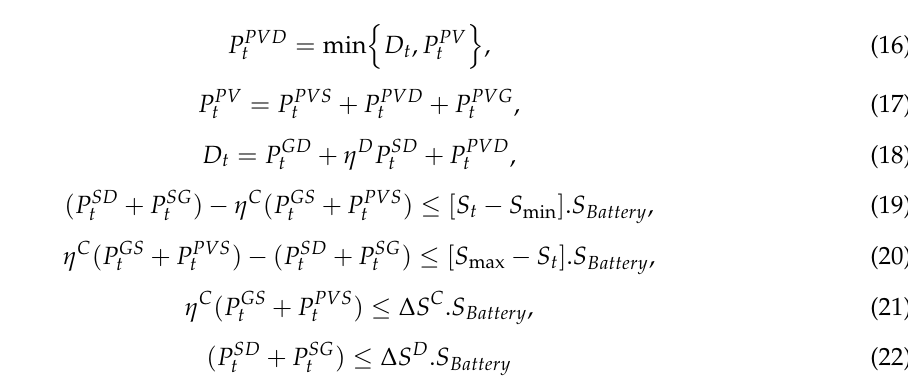
Figure 3. The power production of the photovoltaic (PV) with an average of 500 paths. Figures 4–6 exemplify the ESS level for the distinct types of management strategies under three confidence levels: β = 0.9, 0.95, and 0.99. As can be seen from the abovementioned figures, the simple policy forces the ESS to be discharged to the lowest possible amount as quick as possible and, yet, maintain it in this setting for the remaining duration of the time horizon. Besides, through the use of the risk neutral policy, it will discharge and charge the ESS as soon as the estimated price will be dropping and raising, respectively, while the oscillations of the price of the electricity are not taken into account. Such type of exchanging among maximum and minimum charge levels depends on and